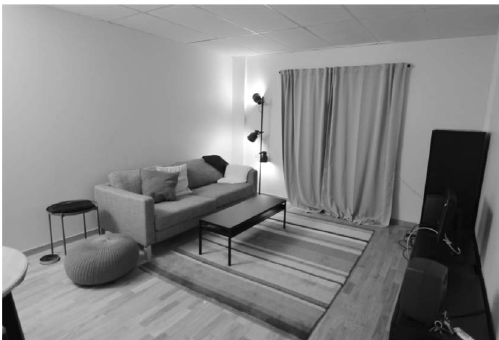
Figure 1. The living room lab at Chalmers, Applied